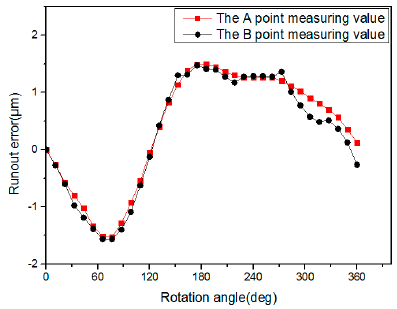
Figure 7. Measurement of run-out of a lower center.